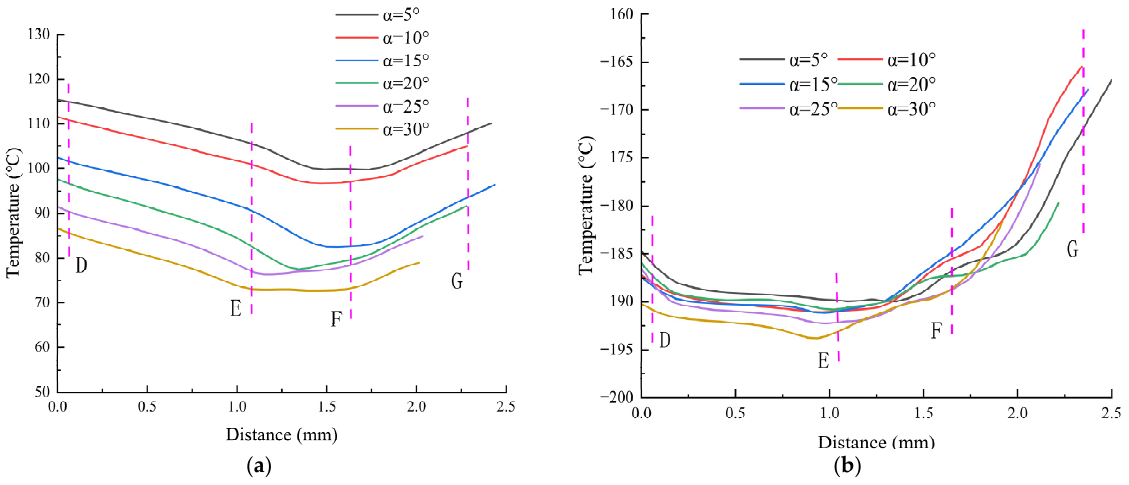
Figure 13. Variation curves of temperature of the fins along the trajectory direction under different conditions: ( a ): RT-EM; ( b ): CT-EM.